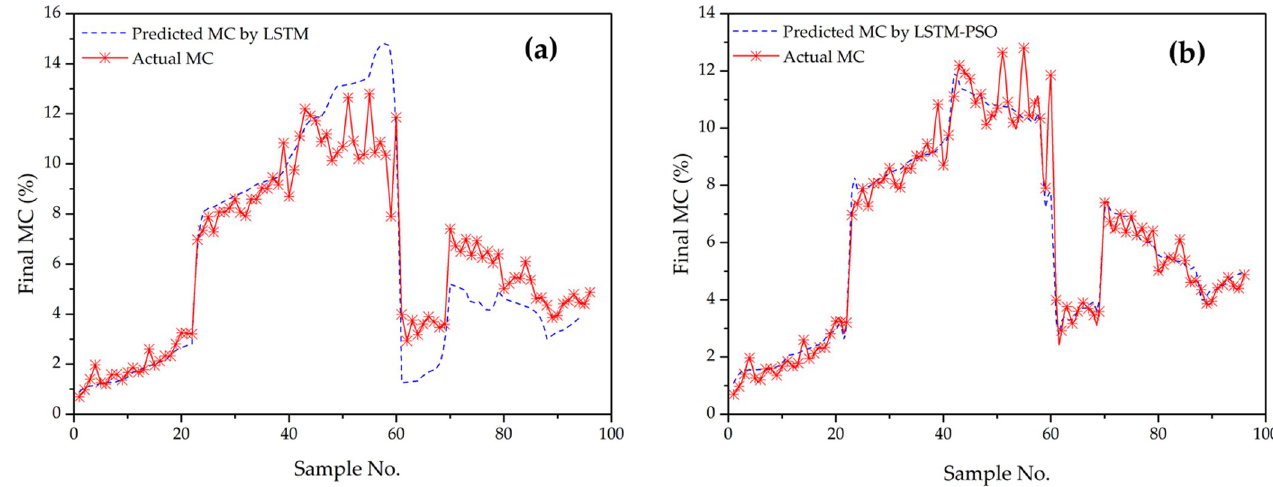
Fig 16. Actual value and predicted value of the LSTM and